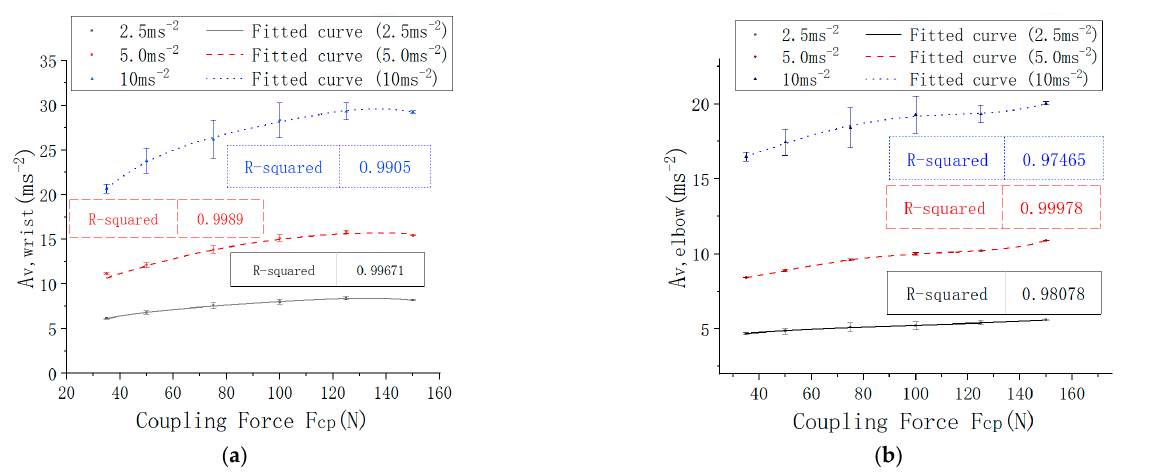
Figure 4. Influence of the level of vibration excitation on the mean vibration total value measured at ( a ) the wrist and ( b ) elbow for different values of the coupling force. ( a ) the wrist and ( b ) elbow for different values of the coupling